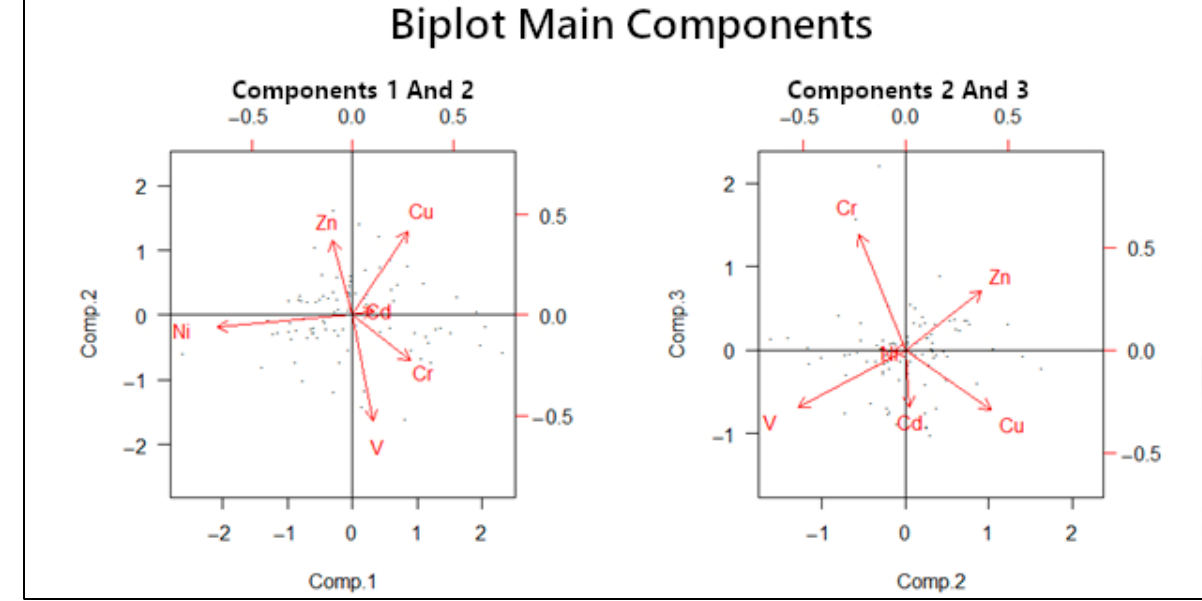
Figure 2. Biplot first 3 main components.